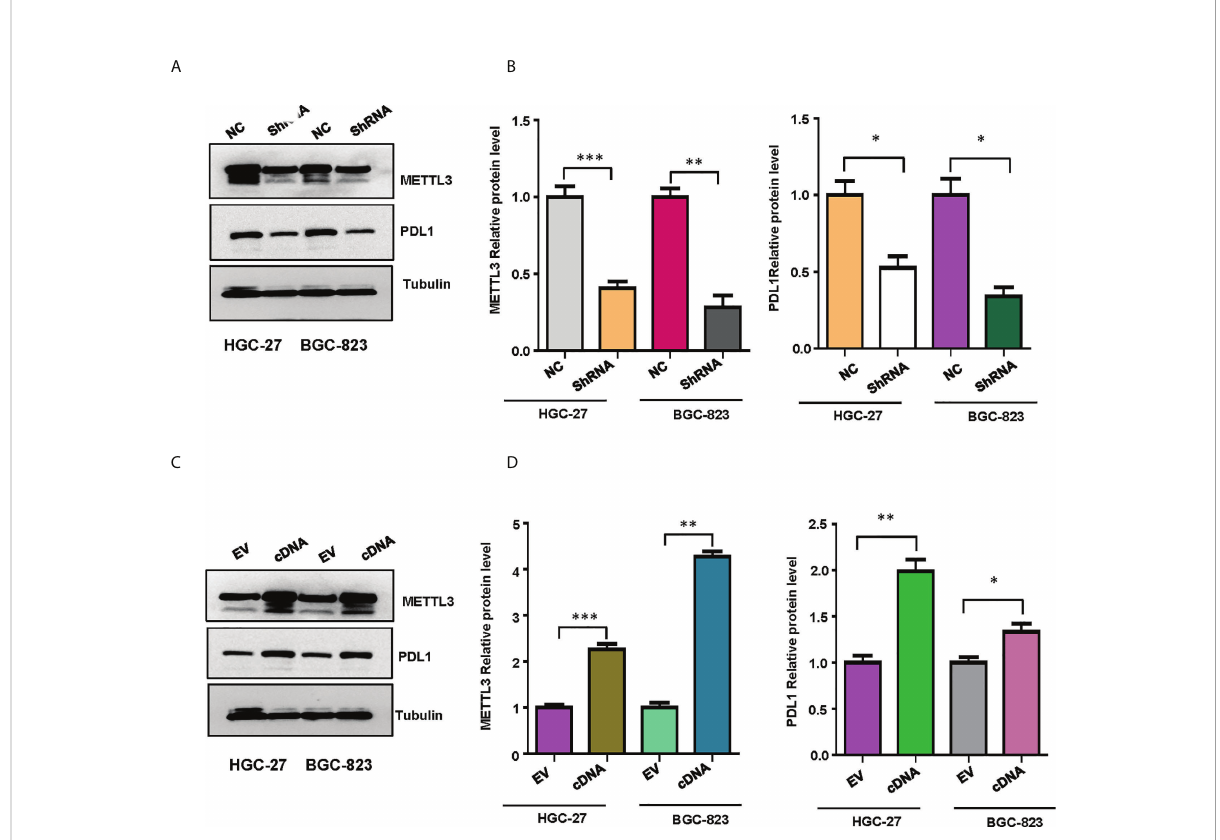
FIGURE 10 The expression of METTL3 and PD-L1 in gastric cancer cells was illustrated. (A) , Western blotting was performed to measure the expression of METTL3 and PD-L1 in HGC-27 and BGC-823 cells after METTL3 downregulation. (B) , Quantitative data were shown for panel (A) . (C) , Western blotting was performed to measure the expression of METTL3 and PD-L1 in HGC-27 and BGC-823 cells after METTL3 overexpression. (D) , Quantitative data were shown for panel (C) . *p<0.05; **p<0.01;